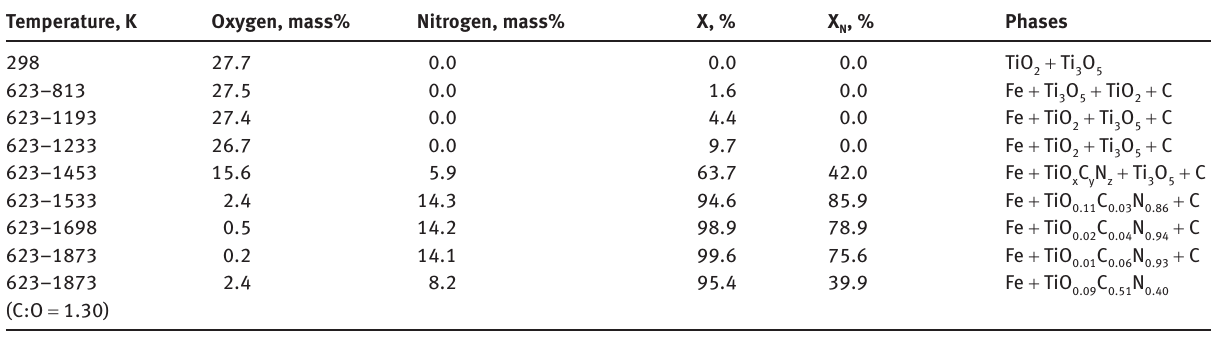
Table 2: LECO analysis and phase composition of synthetic rutile after temperature programmed reduction to different temperatures in the H -N gas mixture (C:O = 1.45) 2 2